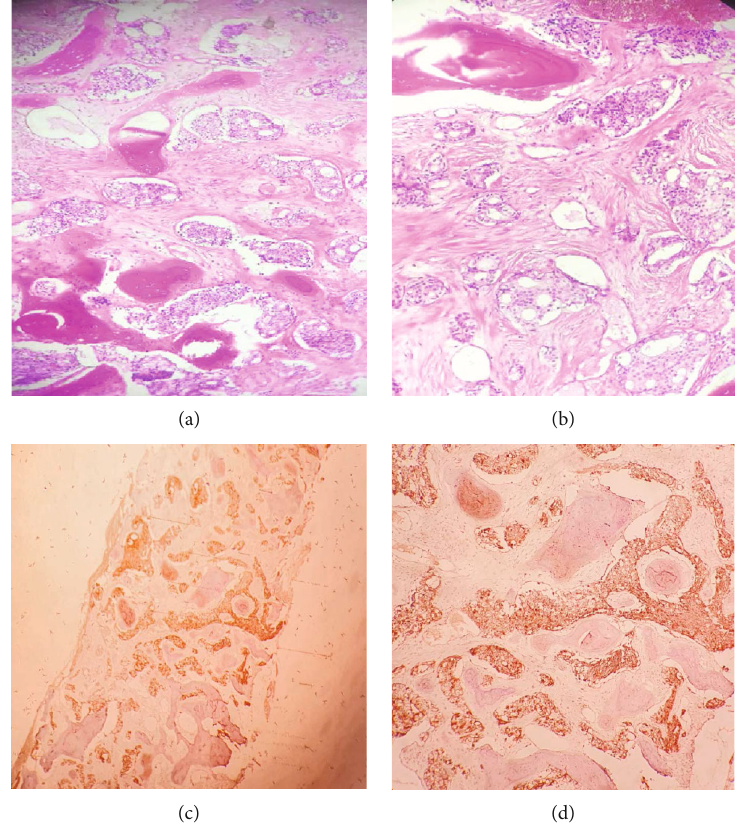
Figure 1: (a, b) Hematoxylin eosin ( × 100): medullary in fi ltration by an acinar adenocarcinoma of the prostate. (c) BOM immunohistochemistry: positive labeling of tumor cells by the anti-PSA G antibody ( × 40). (d) BOM immunohistochemistry: positive labeling of tumor cells by the anti-PSA G antibody ( ×